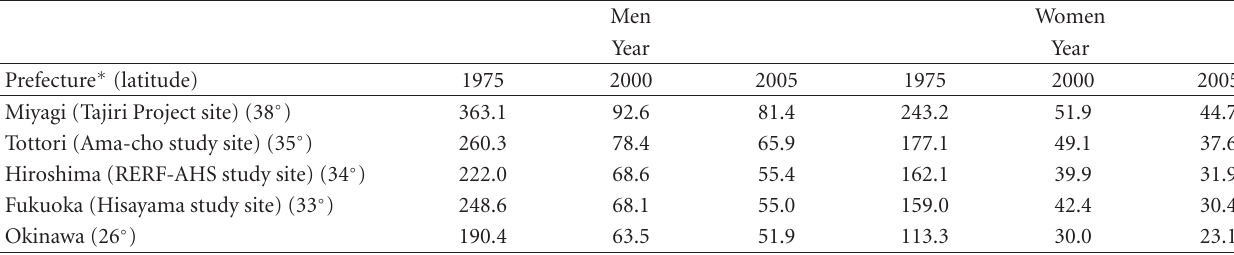
Table 4: Cerebrovascular mortality for the selected prefectures in Japan (per